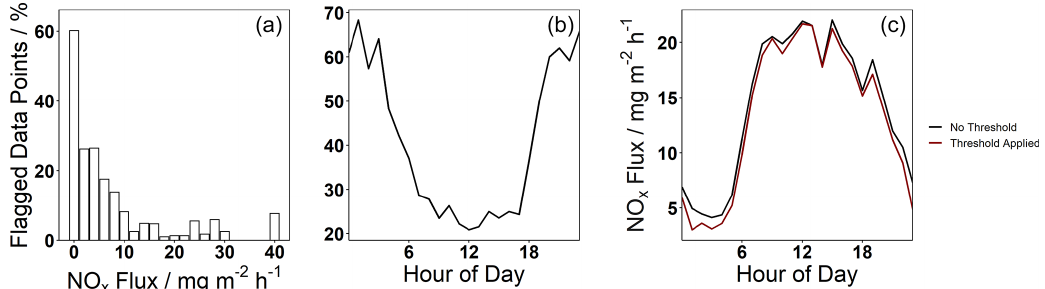
Figure 4. (a) Percentage of flux records flagged by quality control routines in 2mgm − 2 h − 1 bins. (b) Percentage of flux records flagged by quality control routines by hour of day. (c) NO x flux diurnal cycle; black has had all records flagged by quality control routines removed, and red has only had them removed if the flux magnitude was also greater than 5mgm − 2 h − 1 .